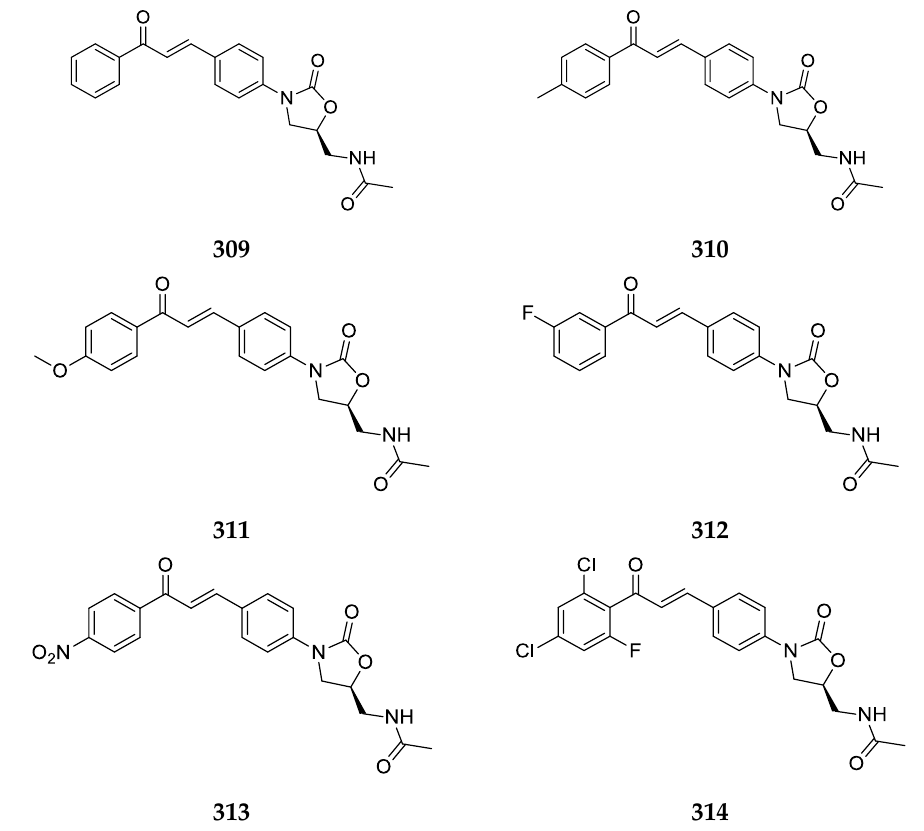
Figure 78. Chemical structure of N -acyl-4′-aminochalcone derivatives with substitution on ring A.